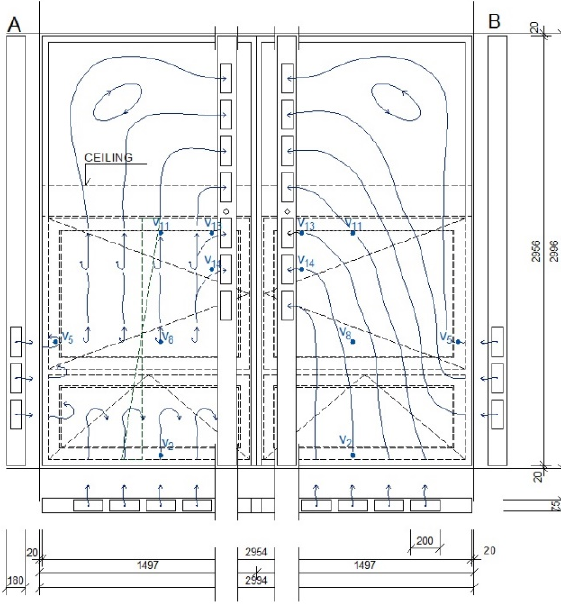
Figure 20: Schemes of air temperature rise in the cavity of a double facade ∆Θ (K). A - windows of the inner wall of the double facade am closed B - windows of the inner wall of the double facade